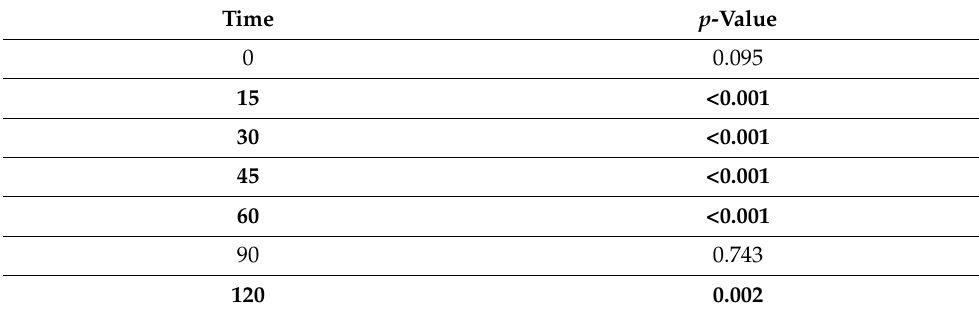
Table 8. One-way ANOVA test (six pasta sessions and two reference food